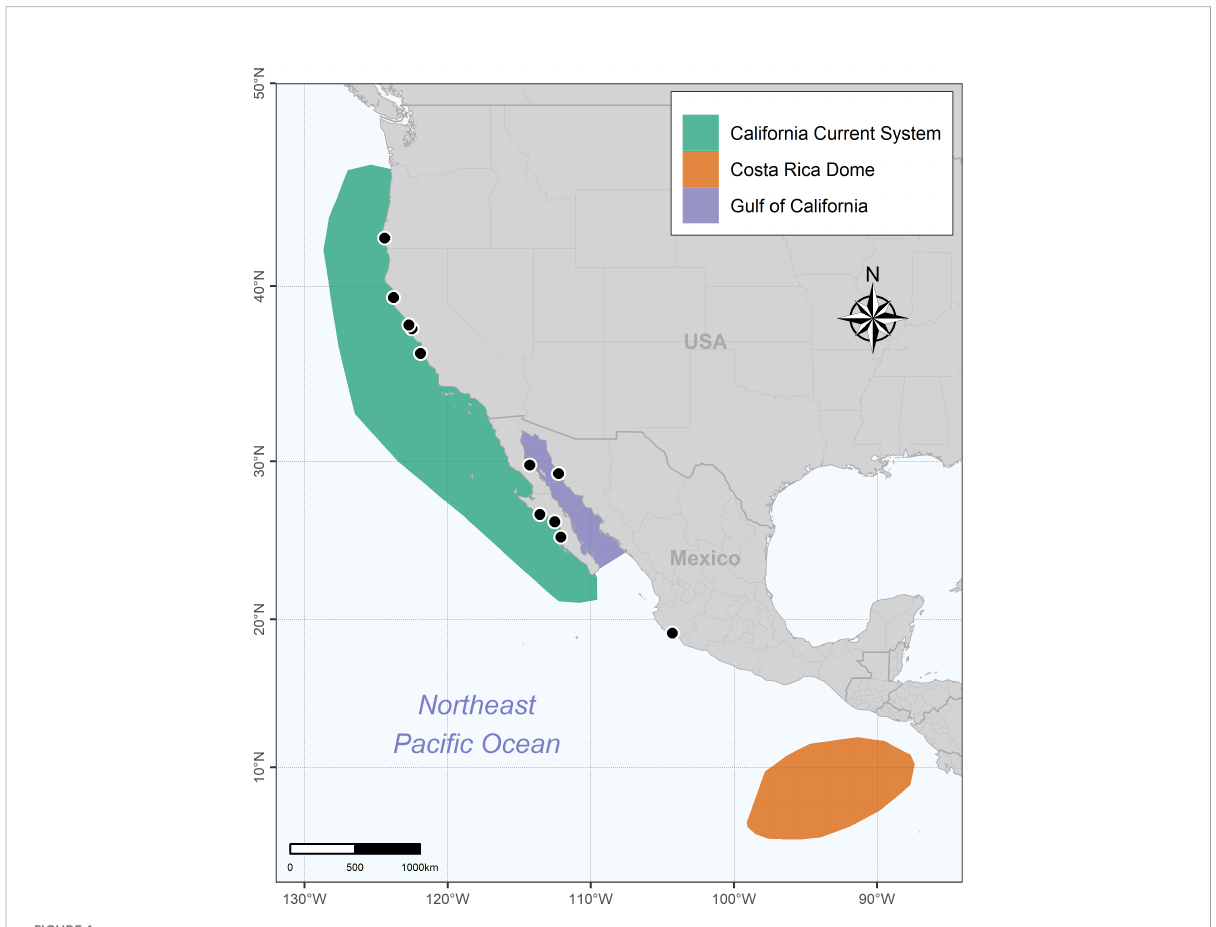
FIGURE 1 Map showing the twelve stranding locations (black dots) from which blue whale baleen plates were collected. Note that the exact stranding location for whale F was not available, although it was con fi rmed that the stranding occurred somewhere in California, USA, in the 80s. The map also shows the regions that blue whale typically visit in the northeast Paci fi c Ocean, including the California Current Ecosystem (CCE), Gulf of California (GC), and Costa Rica Dome